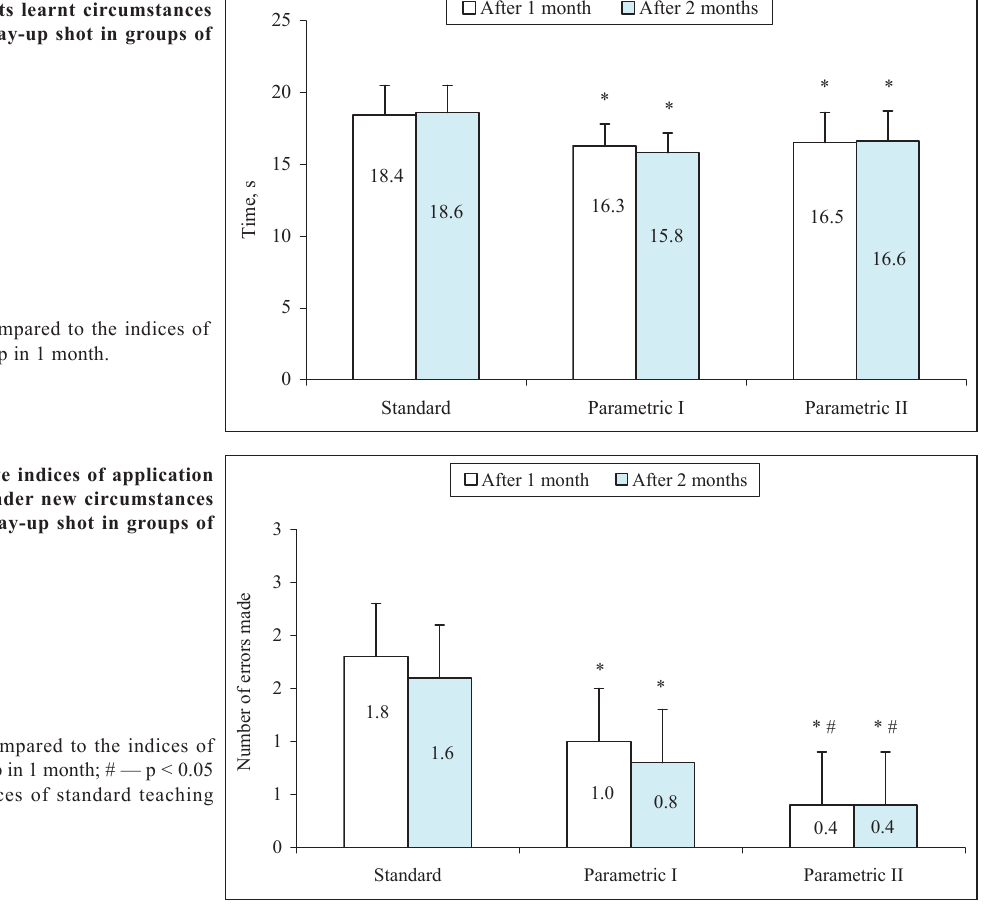
Fig. 9. The qualitative indices of application movements learnt under new circumstances when performing a lay-up shot in groups of different teaching